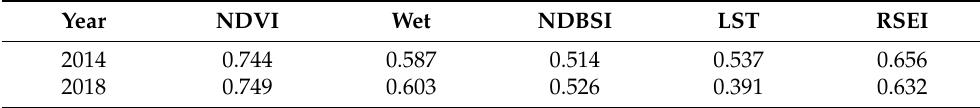
Table 3. The values of ecological indicators and